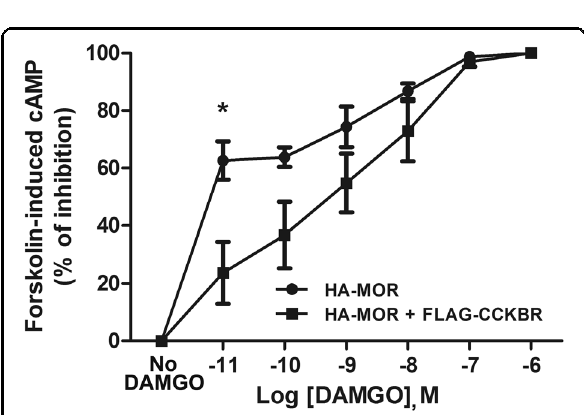
Fig. 6 Heteromerization of MOR and CCKBR reduced inhibition of cAMP accumulation by DAMGO-activated